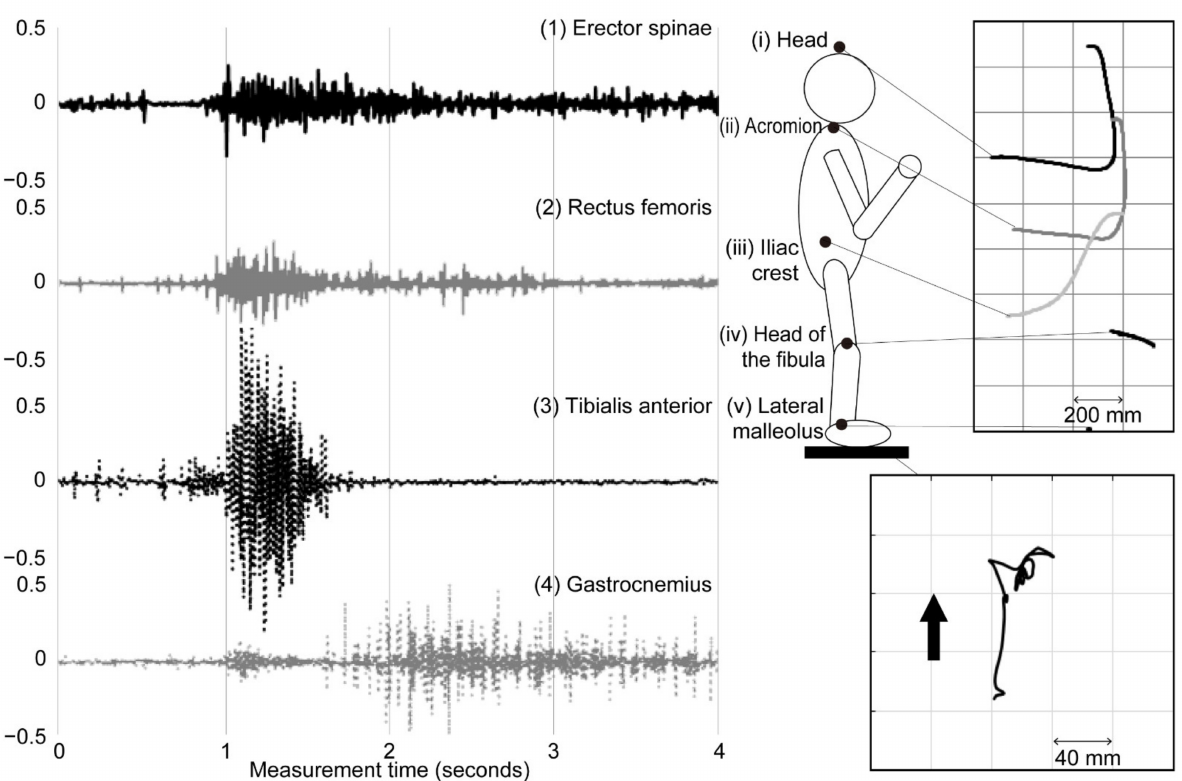
Figure 3. Example of raw data of the standing-up motion among older participants with a toilet seat angle of 5 ◦